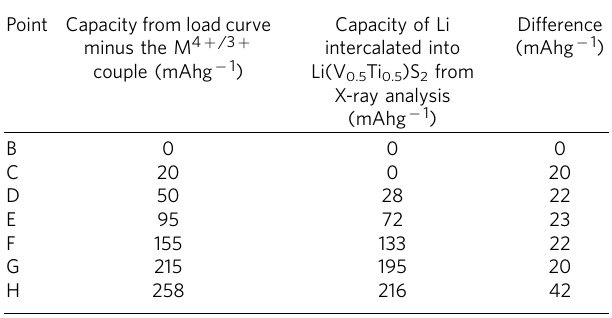
Table 1 | Comparison between capacity observed electrochemically and intercalated capacity derived from X-ray refinements.